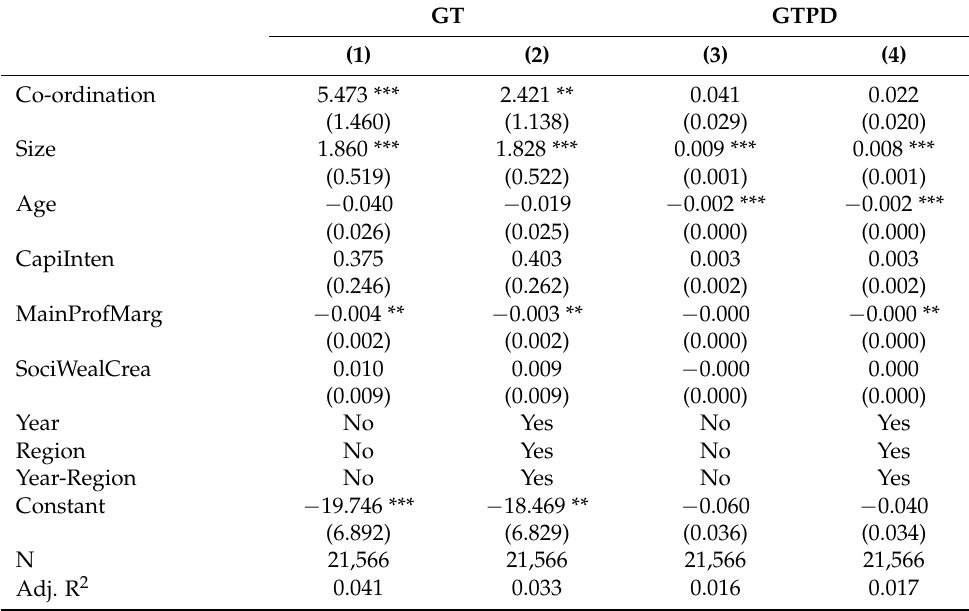
Table 3. The impact of HQCD on green technology choice.